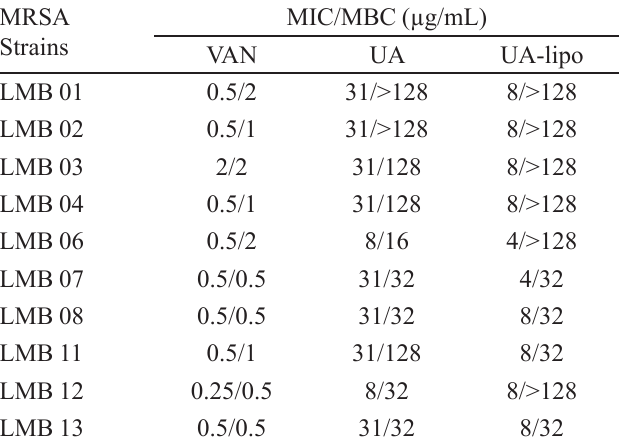
TABLE I - Antibacterial activity of vancomycin, usnic acid and liposomes containing usnic acid against methicillin-resistant Staphylococcus aureus clinical isolates MRSA